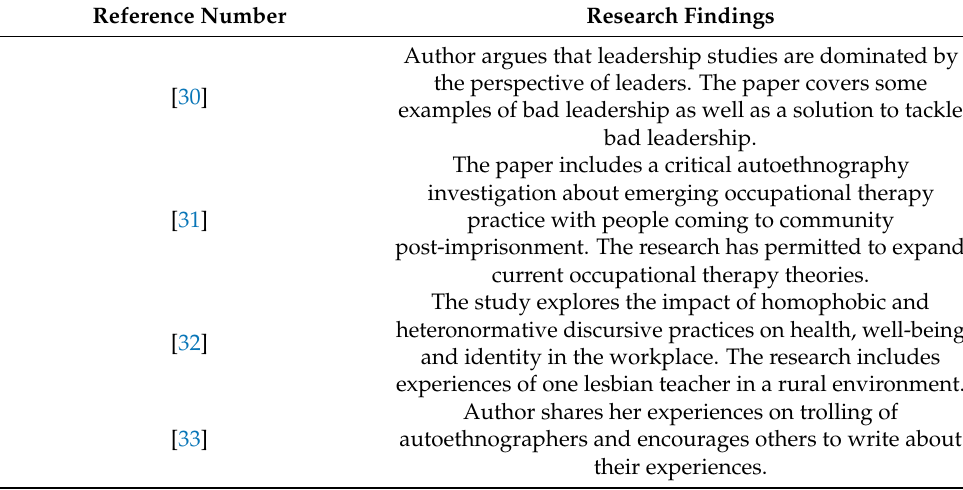
Table 1. Autoethnography research publications on societal problems.